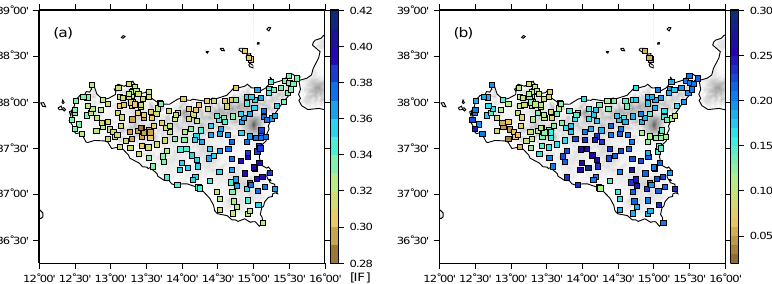
Figure 9. Spatial distribution of best guess values of (a) the scale (IF units) and (b) the shape parameters from RFA fits to rescaled annual maxima at the station points.